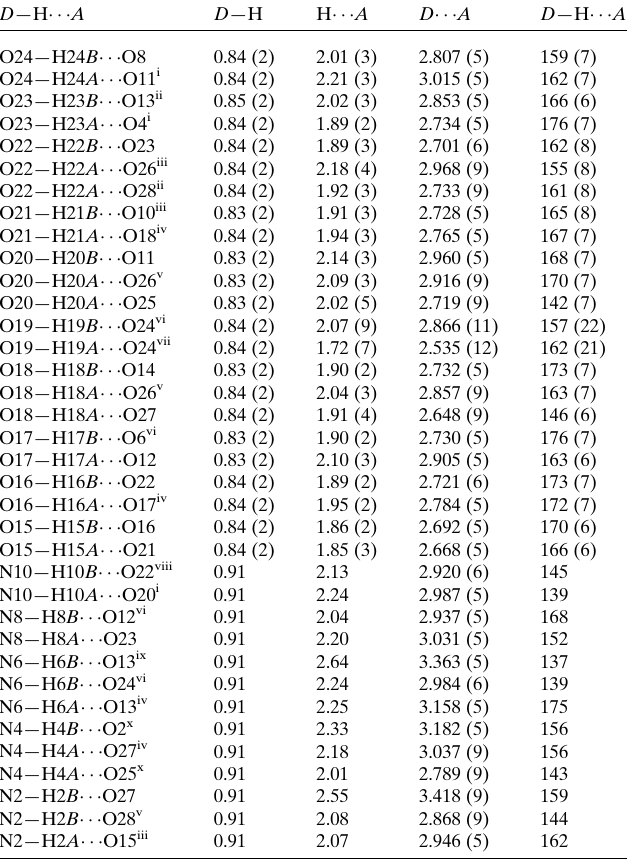
Table 4 Hydrogen-bond geometry (A˚ , (cid:5)